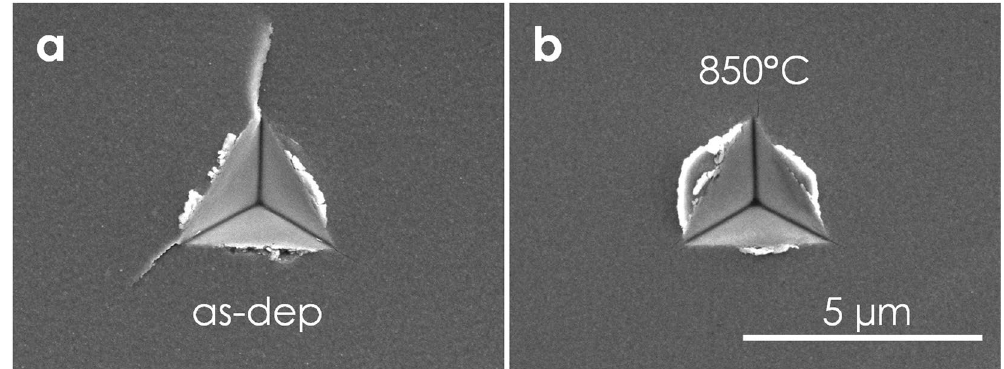
Figure 6. Cube corner nanoindentation experiments reveal aggravated (or even impeded) crack formation for annealed ( b ) as compared with as-deposited ( a ) Ti 1 − x Al x N coatings on sapphire